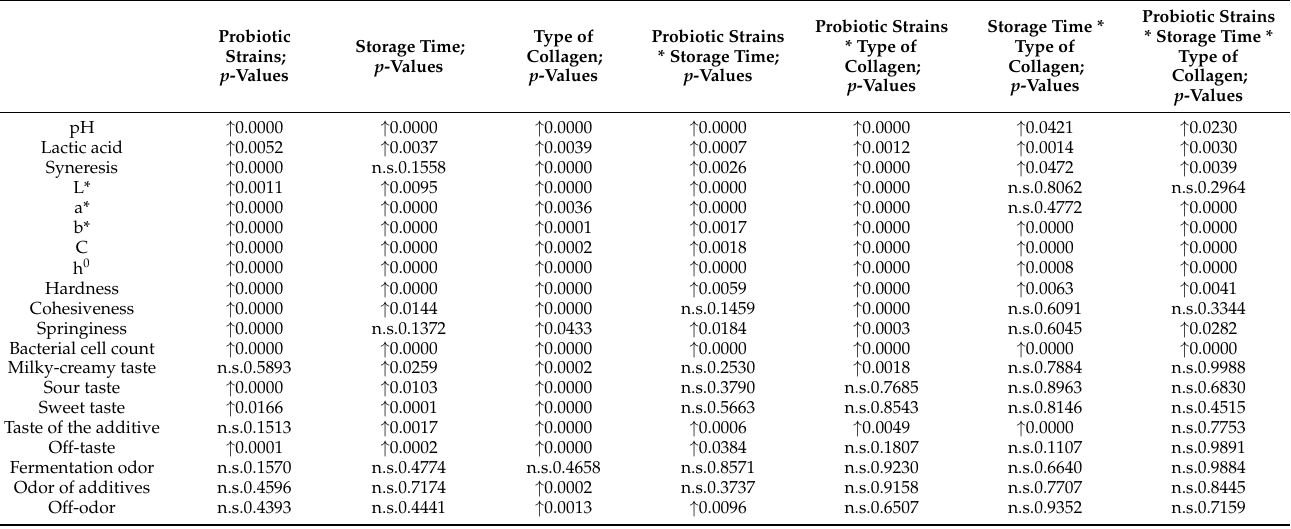
Table 5. Analysis of variance (ANOVA) p -values on the effects of probiotic strains, storage time and type of collagen on pH, total acidity, syneresis, color (L*, a*, b*, C, h 0 ) hardness, cohesiveness, springiness, bacterial cell count, milky–creamy taste, sour taste, sweet taste, taste of the additive, off-taste, fermentation odor and off-odor of fermented sheep’s